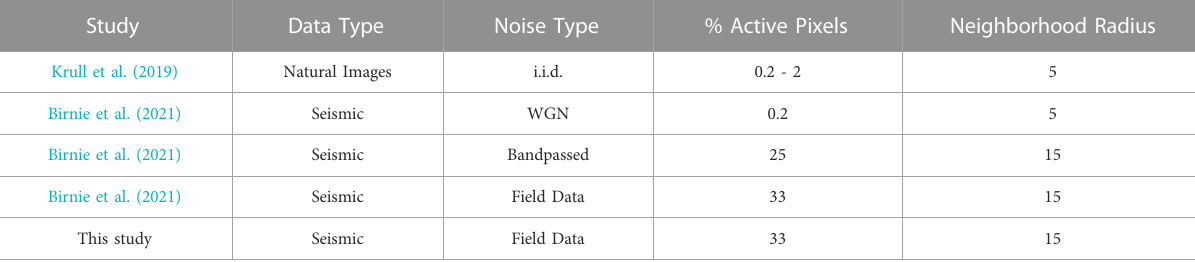
TABLE 1 Blind-spot network parameters for different data and noise types.